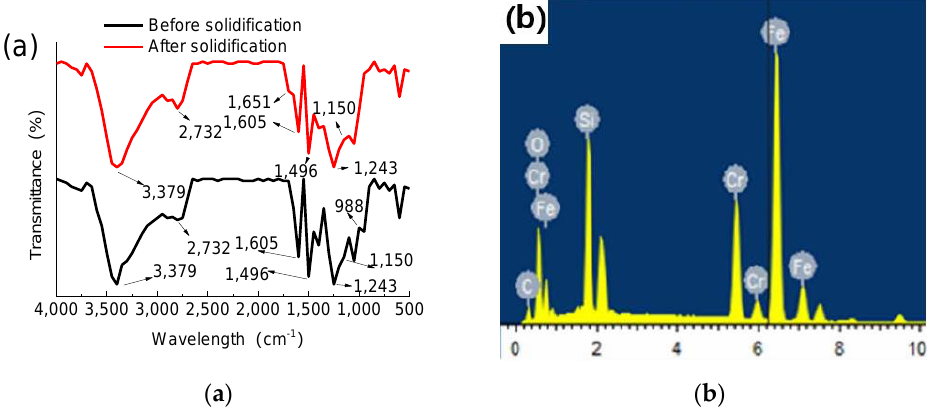
Figure 4. ( a ) Infrared spectra of phenolic resin before and after curing at 160 °C. ( b ) Element content of superhydrophobic and superhydrophobic SiO 2 /phenolic resin filter film.